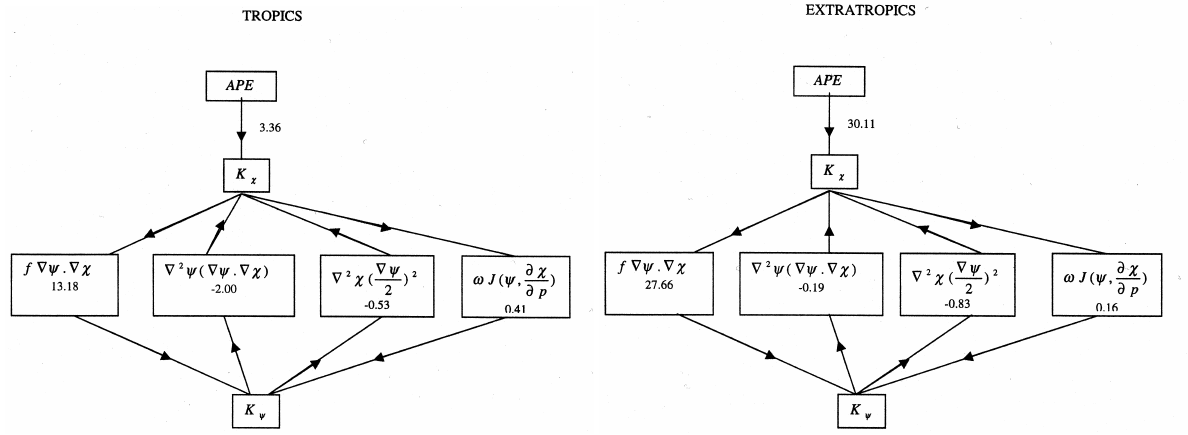
Fig. 3. Schematic energy cycle diagram of the atmospheric system. Arrows denote the most likely direction of the conversion between energy components for (a) tropical and (b) extratropical South America. Values of energy exchanges are within the boxes. The values are multiplied by 10 − 3 m 2 s − 3 .